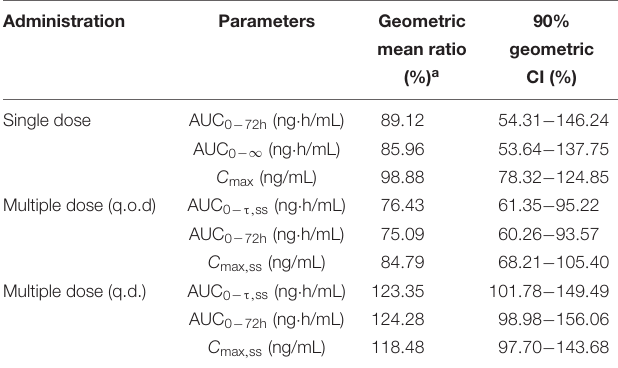
TABLE 3 | Pharmacokinetic parameters of progesterone after single dose of vaginal progesterone gel. Parameter